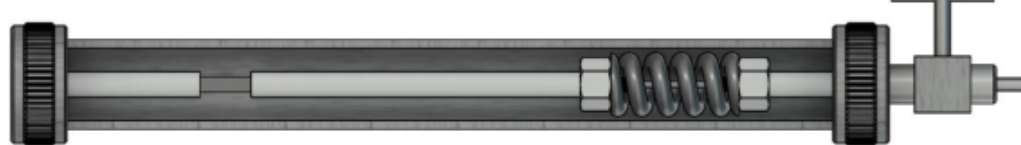
Figure 2. Experimental setup of the autoclave tests